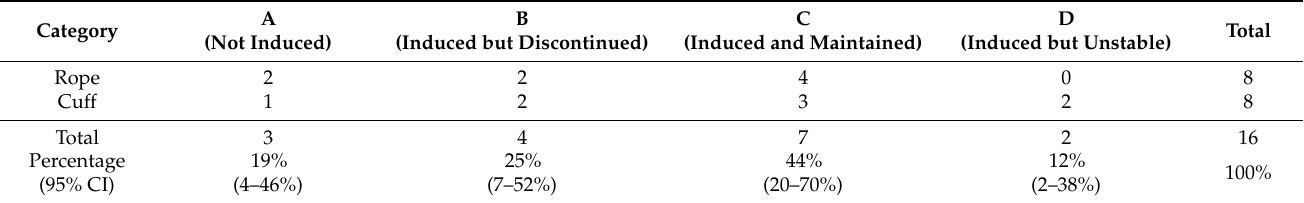
Table 2. Number and proportion (with 95% confidence intervals) of calves in each induction category, according to the method of squeeze application. See Section 2.6 for a description of the induction